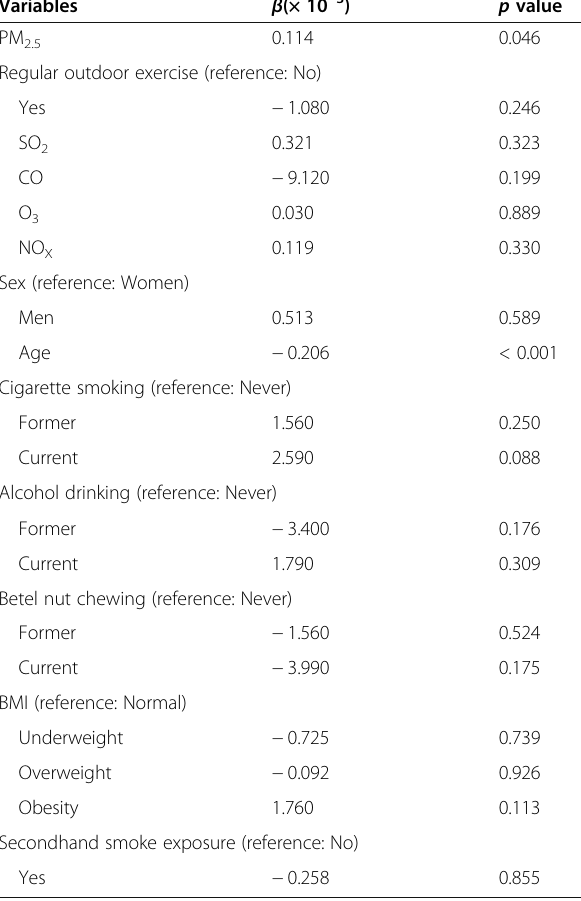
Table 2 Multiple linear regression showing the association of PM 2.5 and outdoor exercise with DLEC1 promoter methylation in